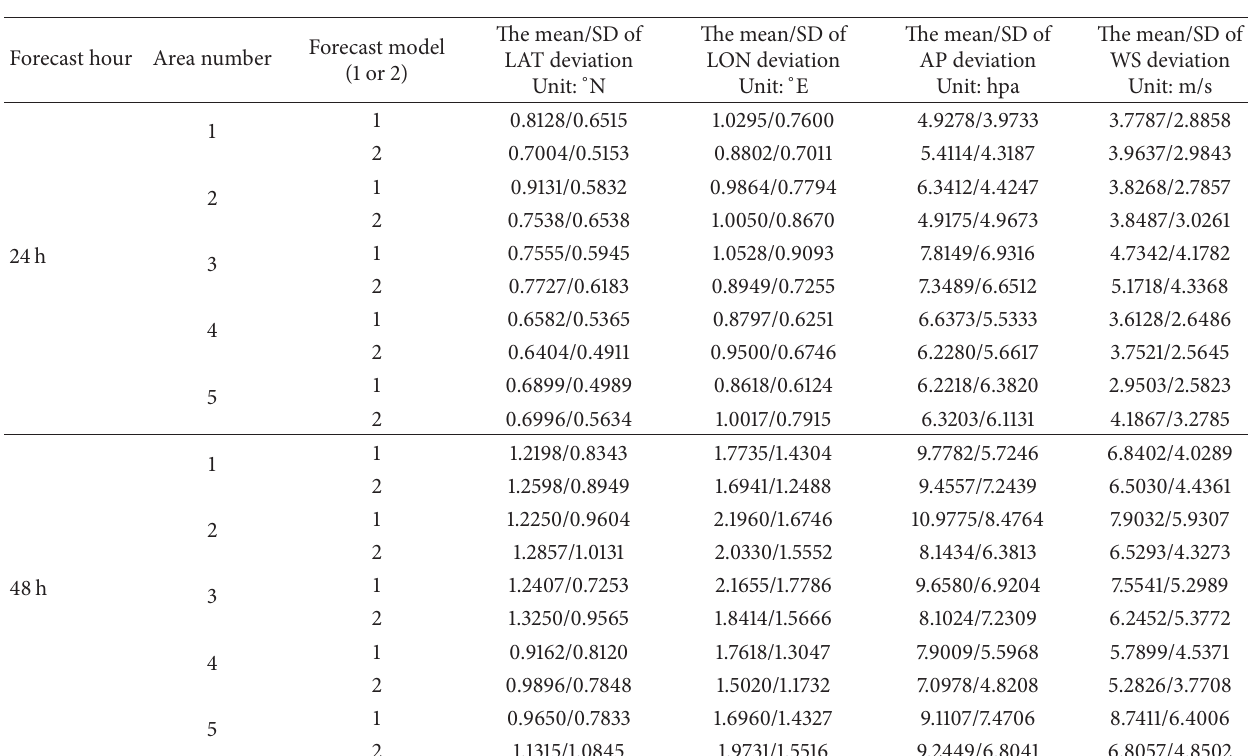
Table 8: The results of testing forecast model 1 and forecast model